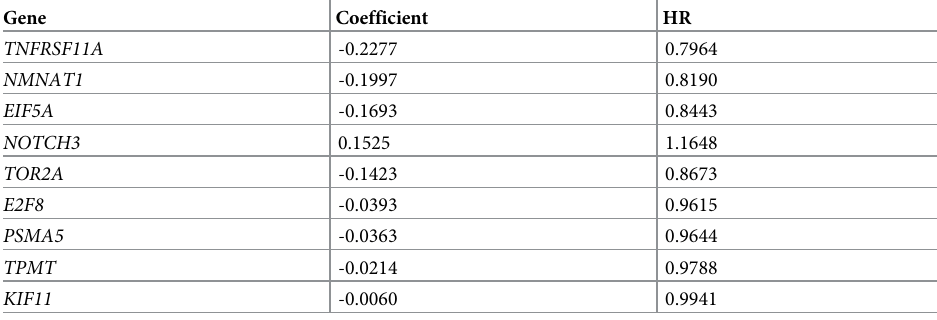
Table 3. Bayesian hierarchical lasso Cox model of 9 genes associated with OS in GC